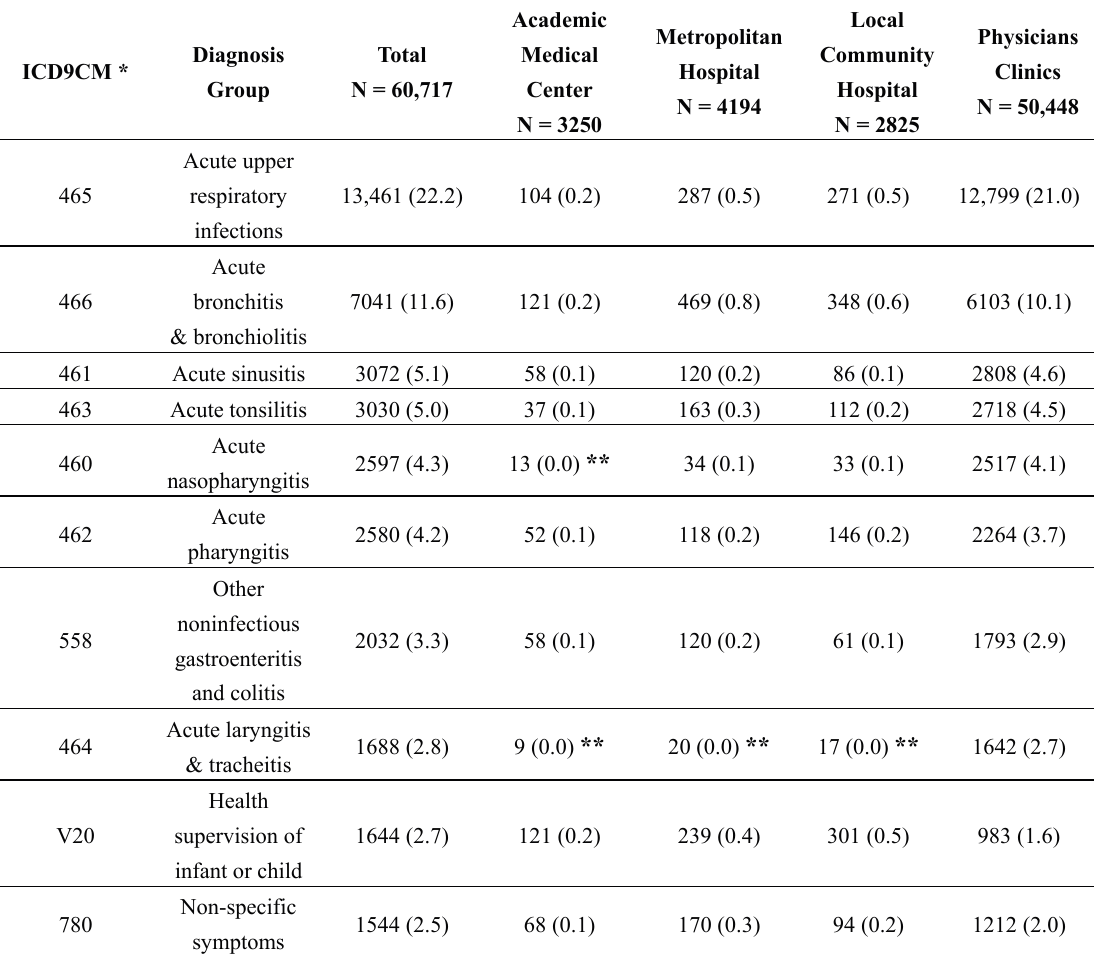
Table 3. Ambulatory visits to pediatricians, data from Taiwan’s National Health Insurance in 2012, stratified by disease group and hospital level (sampling rate: 1/500, the percentage of diagnoses had been rounded).